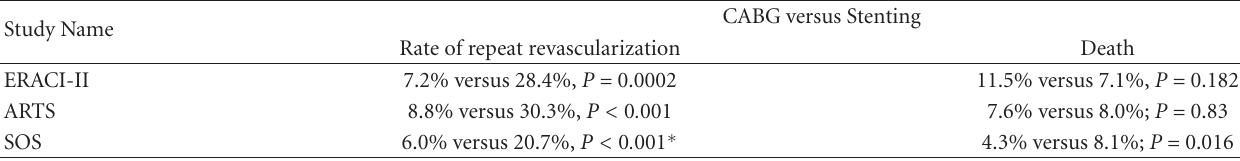
Table 1: Death and repeat revascularization at five years with CABG and